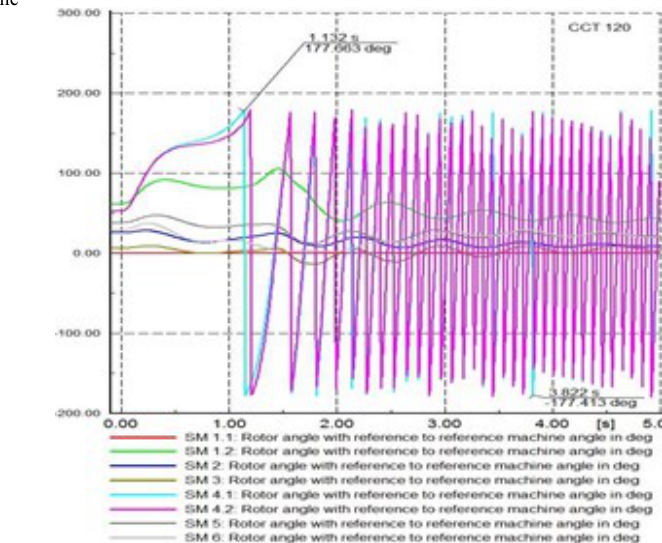
Fig. 13. Generator Rotor angle fault (Without HVDC